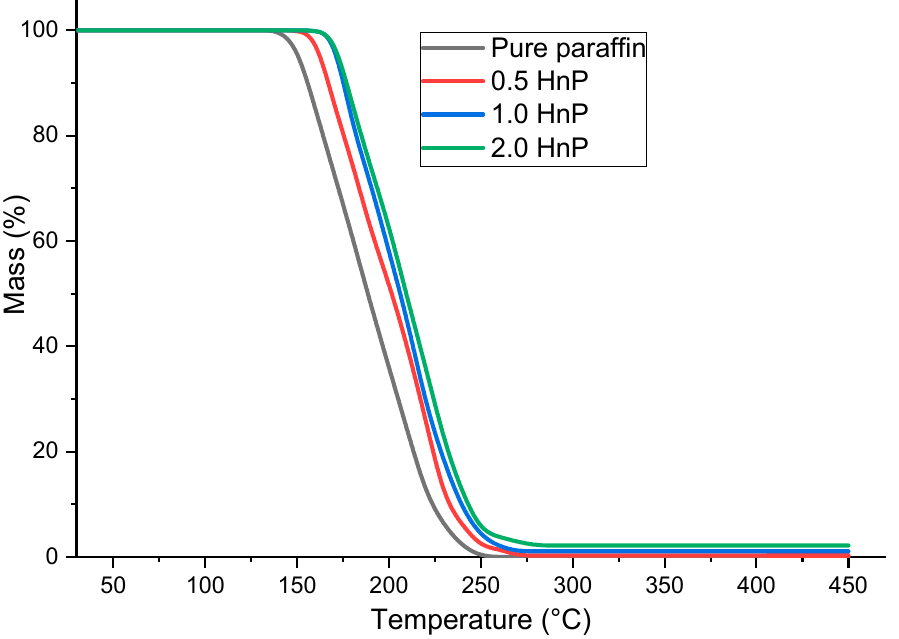
Figure 8. Thermogravimetric analyzer (TGA) plot of the hybrid-nano/paraffin samples.